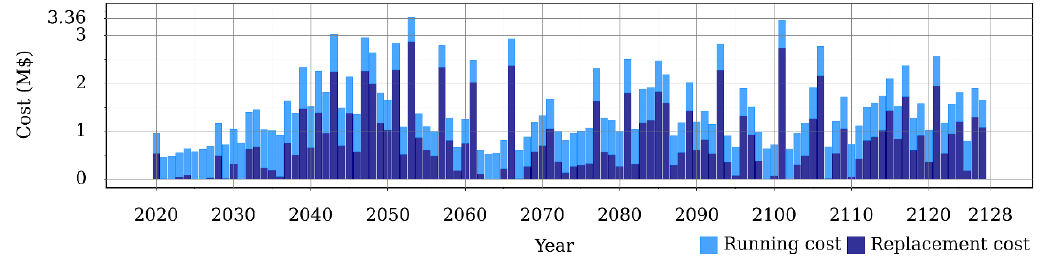
Figure 9. Future investment time series before smoothing.